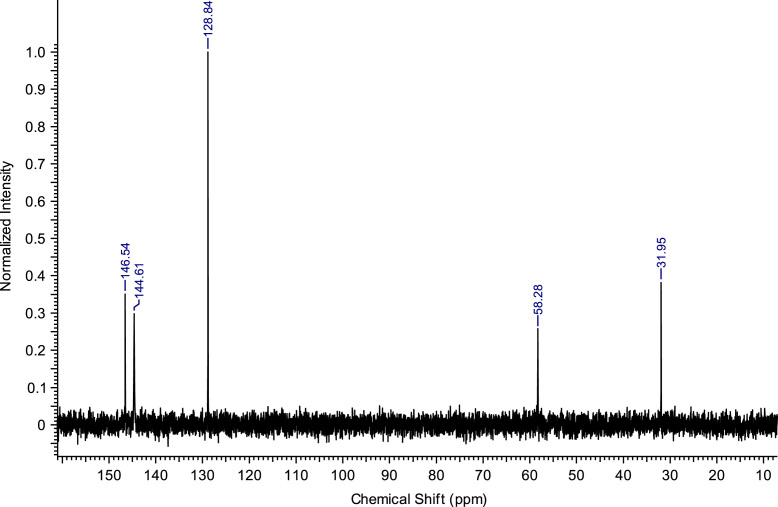
13C NMR spectra of C3(Pyr)2Br2.